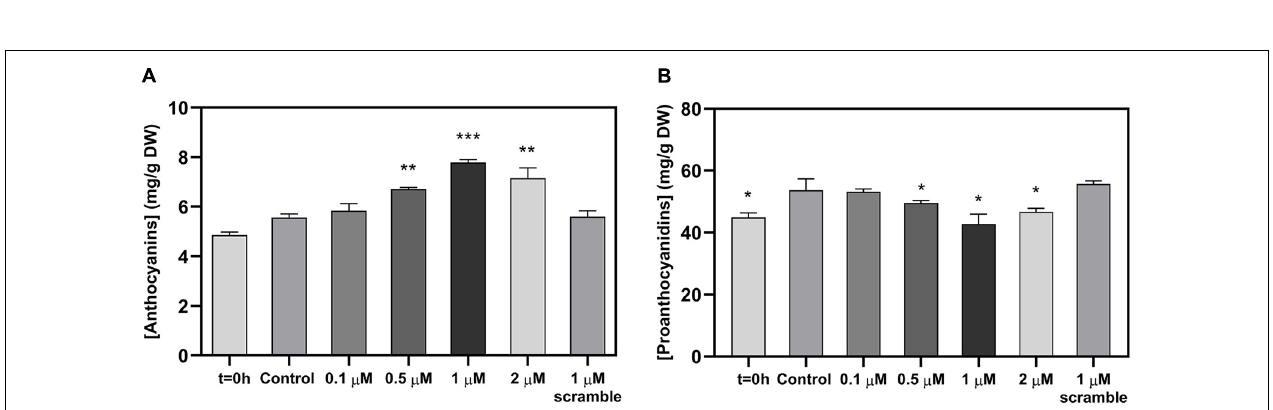
FIGURE 2 | Effect of the exogenous application of different concentrations of miPEP164c on total anthocyanin content (A) and on total proanthocyanidin (PA) content (B) in suspension-cultured grape berry cells (cv. Gamay) 10-day after elicitation with miPEP164c. Anthocyanin concentration is represented as mg of cyanidin-3-glucoside (C-3-G) equivalents per g of fresh weight (FW). Asterisks indicate statistical significance in relation to the control (Student’s t -test; * P < 0.05; ** P < 0.01; *** P < 0.001).